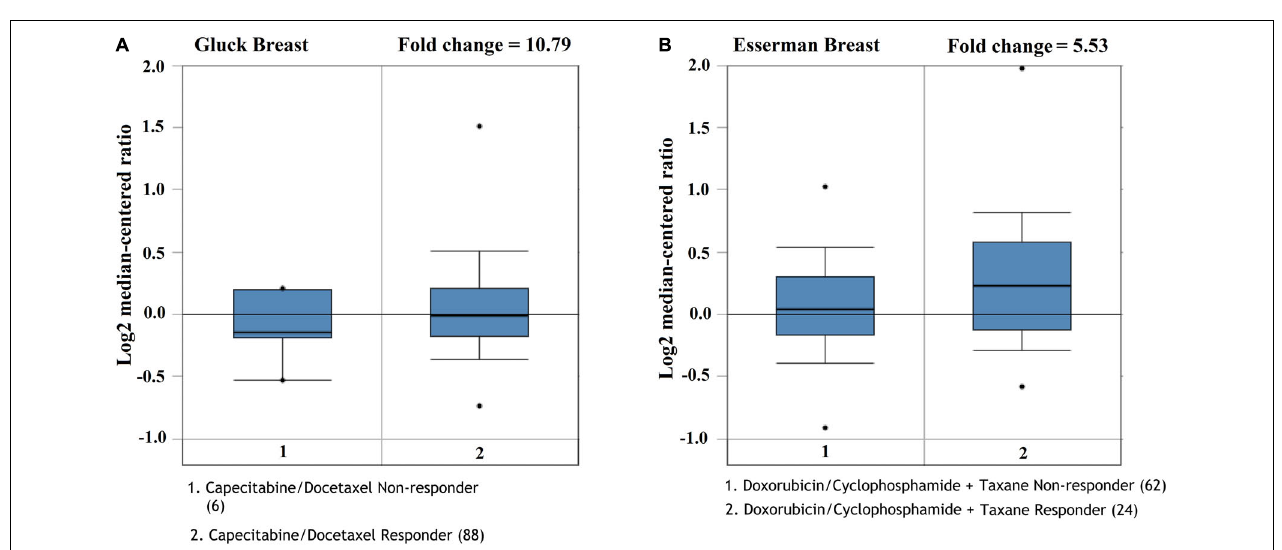
FIGURE 8 | The influence of the expression of CMTM5 on the response to chemotherapeutics in breast cancer ( A , Gluck Breast database; B , Esserman Breast